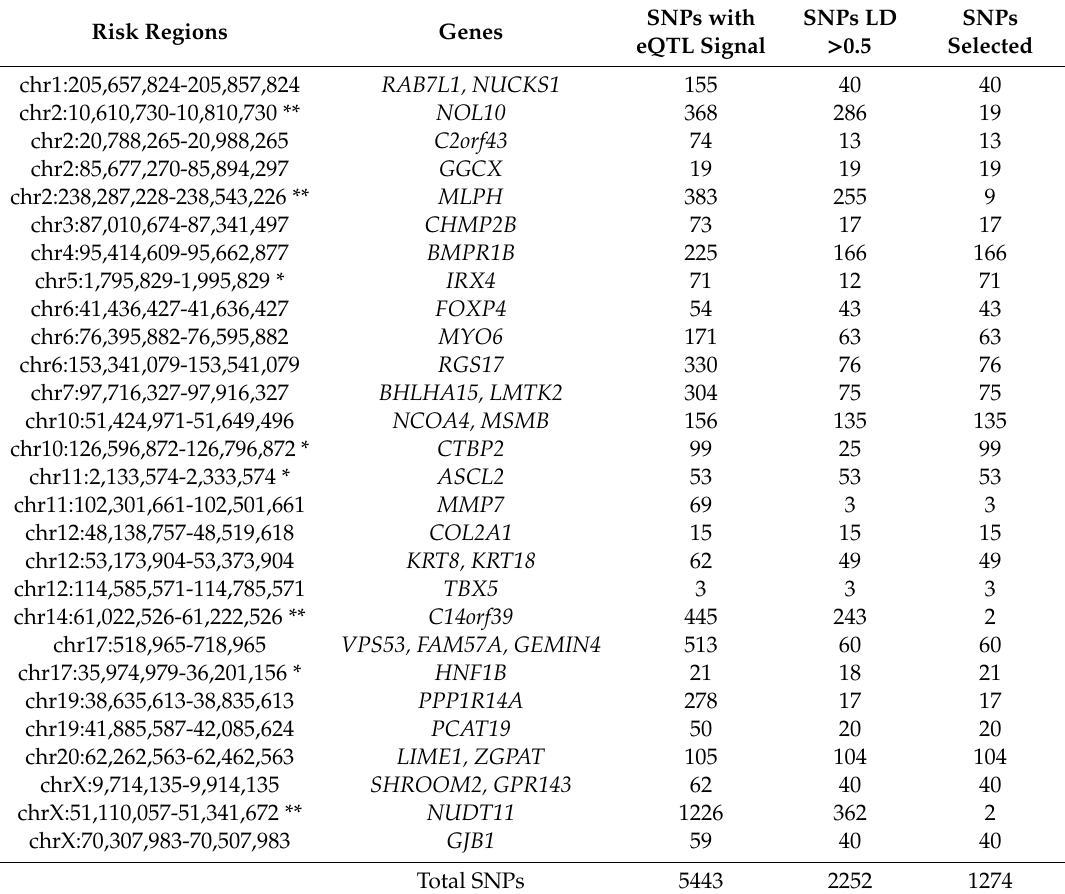
Table 1. Distribution of selected SNPs on 28 regions (36